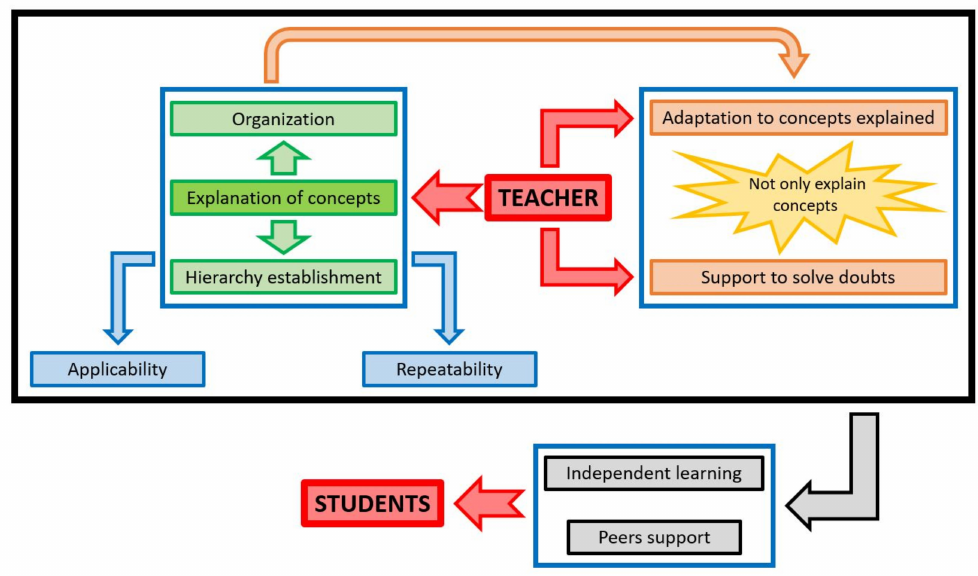
Figure 8. Conceptual diagram of elements needed for successful learning in